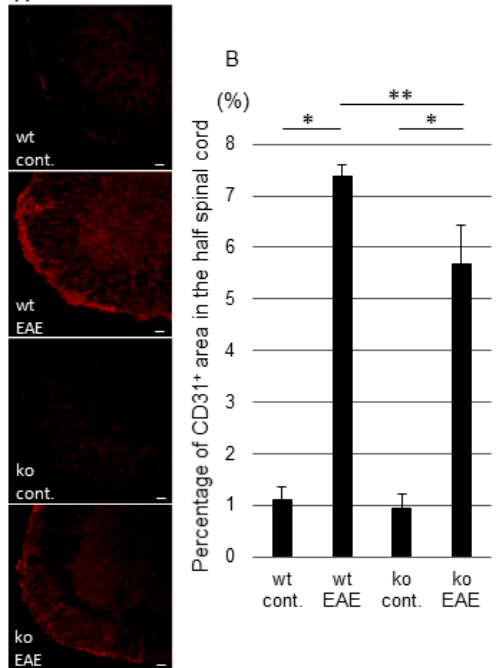
Figure 3. Distribution of CD31-positive (CD31 + ) endothelial cells (ECs) in spinal cords. Immunohistochemical image showing CD31 in the spinal cord in wild-type (wt) control, wt experimental autoimmune encephalomyelitis (EAE), mPGES-1 -deficient ( mPGES-1 − / − ) control, and mPGES-1 − / − EAE mice ( A ). Percentage of the CD31 + area in half of the spinal cord per half the size area of the spinal cord ( B ). Scale bar (50 µ m); wt, wild-type; ko, mPGES-1 − / − ; cont., naïve mice; EAE, EAE mice. * p < 0.001, ** p < 0.05.